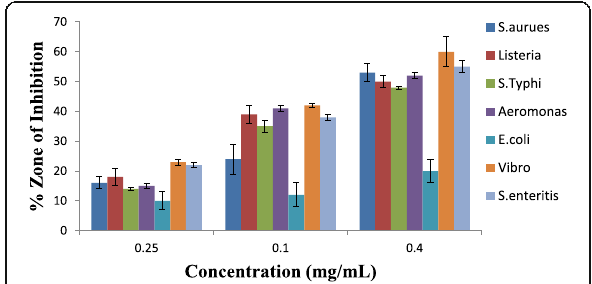
Fig. 2 Antibacterial activity of flower oil of Callistemon citrinus